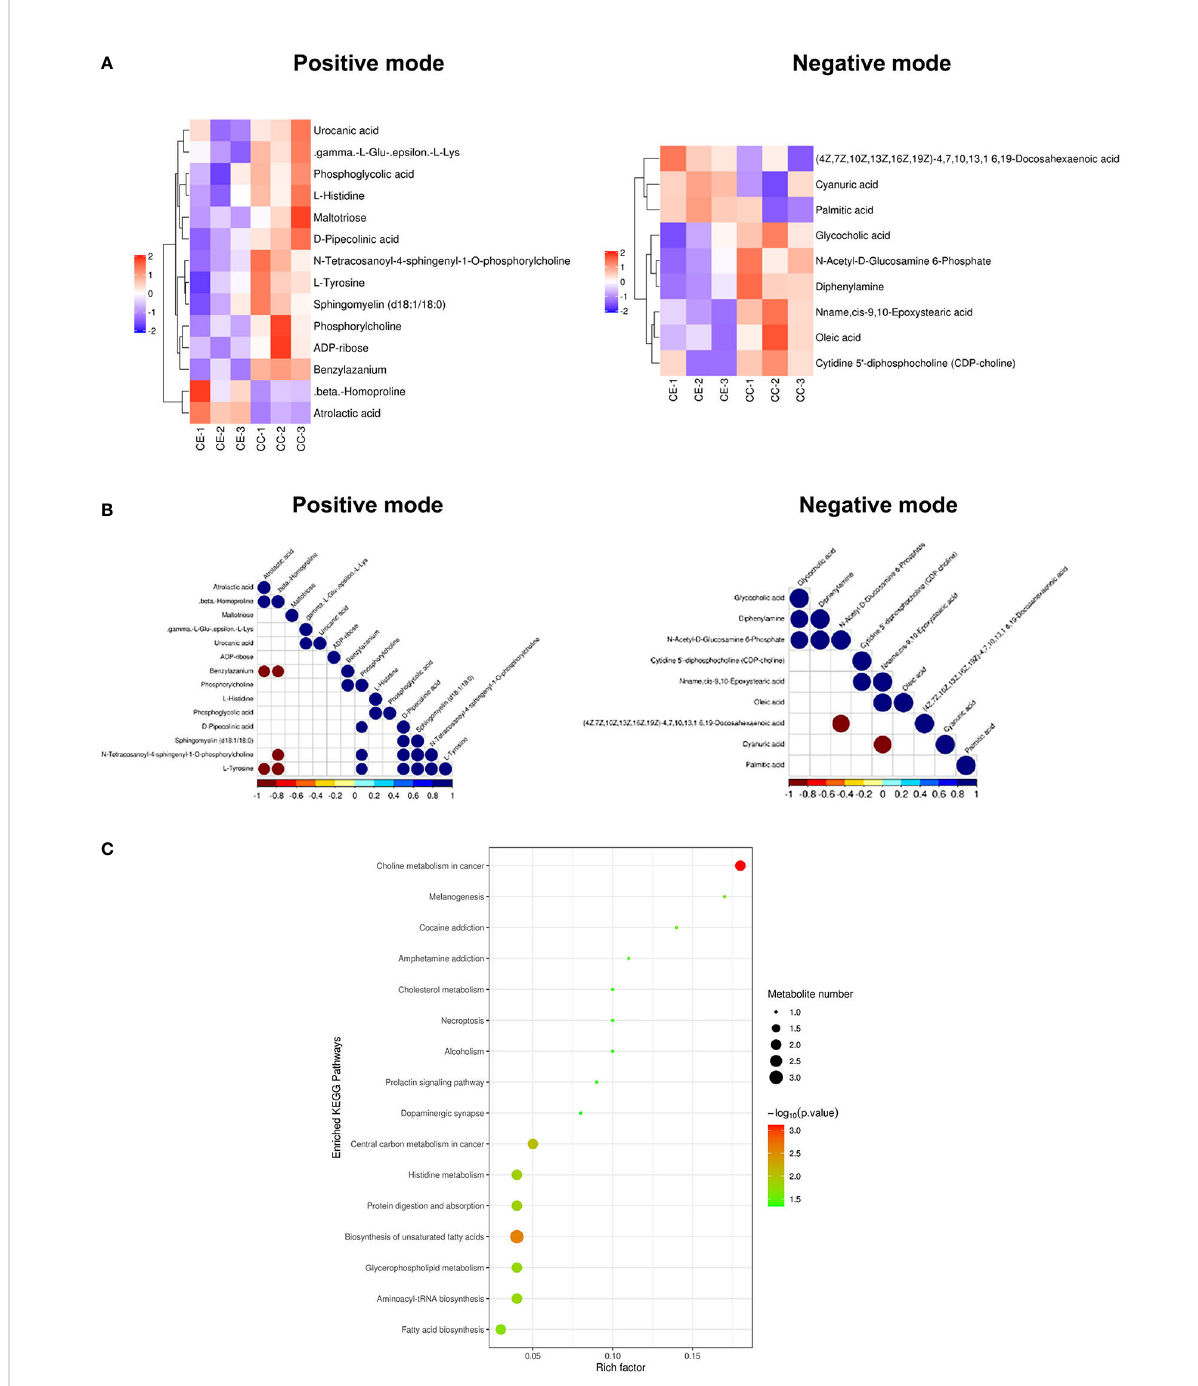
FIGURE 2 Metabolomic analysis of CCs in endometriosis and control women. Heat map of the changes in metabolites related to cumulus cells in endometriosis and control women. A heat map from cumulus cells in the positive ion modes and negative ion modes (A) . These plots display a clear separation between normal and endometriosis metabolomes. Data of heap map plots reveal unit-variance scaling. The blue color represents the trend of reduction, and red color represents an increasing trend. Metabolite – metabolite correlation analysis of cumulus cells in endometriosis and control women in the positive ion modes and negative ion modes (B) . Positive correlations are shown in blue, and negative correlations are shown in red. KEGG-enriched pathways changed between endometriosis patients and control (C) . CCs, cumulus cells; KEGG, Kyoto Encyclopedia of Genes and